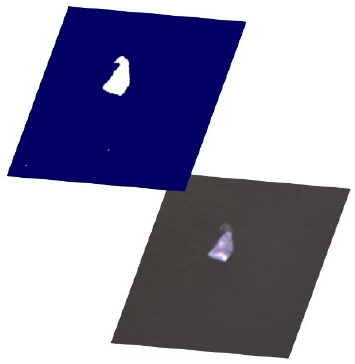
Figure 4. Zoom of Figure 3 on one the plastic